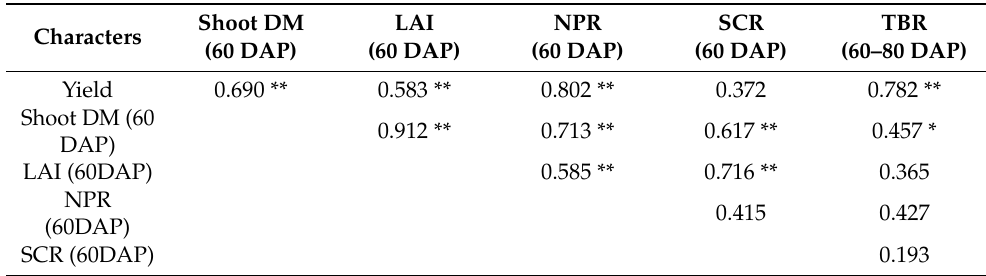
Table 5. Correlation studies between tuber yields and various morphological and physiological